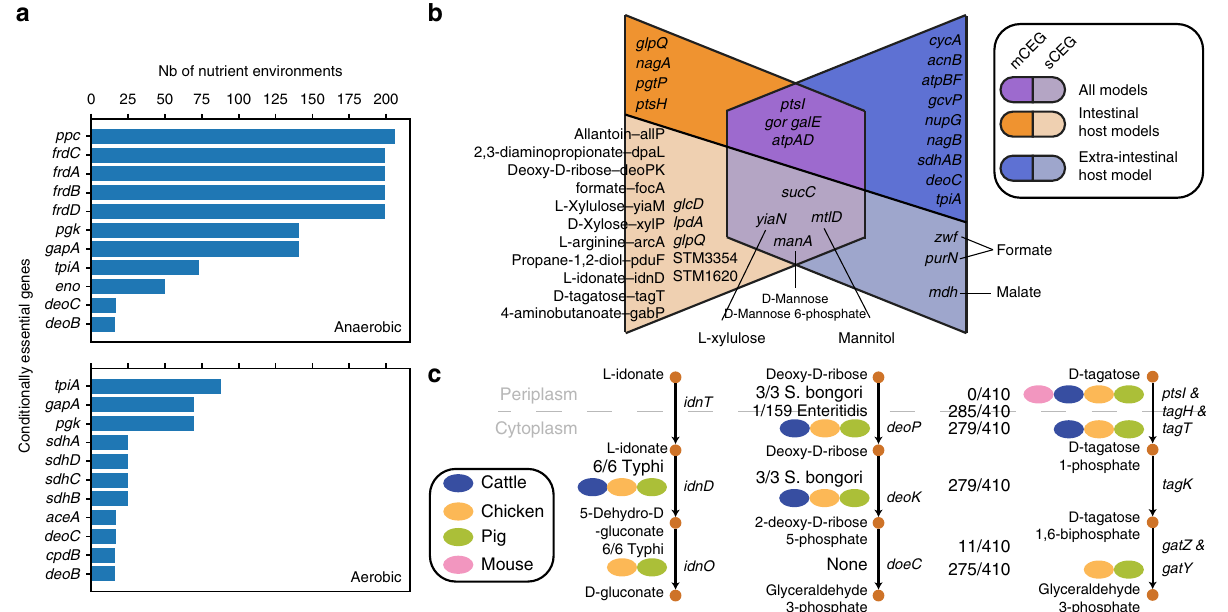
Fig. 6 Conditionally essential genes (CEGs) and corresponding mutant fi tness in diverse hosts. a We searched for CEGs across 531 nutrient environment conditions and found a total of 20 involved in central metabolism. Of the 531 nutrient environments, 242 were anaerobic and 289 were aerobic. We plot here the 10 most frequent CEGs in aerobic and anaerobic conditions. b We selected for CEGs whose corresponding mutant was found to contribute to fi tness in at least one host. We then plotted a venn diagram of CEGs that were observed to be important for fi tness in intraintestinal versus extraintestinal hosts. We subdivided CEGs into those that were predicted to be essential in 5 or more nutrient environments (mCEGs) and those predicted to be essential in less than 5 nutrient environments (sCEGs). c We identi fi ed the occurrence of sCEGs that were seen to contribute to fi tness across strains of Salmonella . We highlight here three catabolic pathways featuring the selected sCEGs and the number of Salmonella strains that do not carry the CEGs in their genome. The genes are placed next to the metabolic process that they are involved in. The fi tness contributions of an sCEG to hosts are highlighted (ovals indicate that a signi fi cantly affected fi tness was measured in this